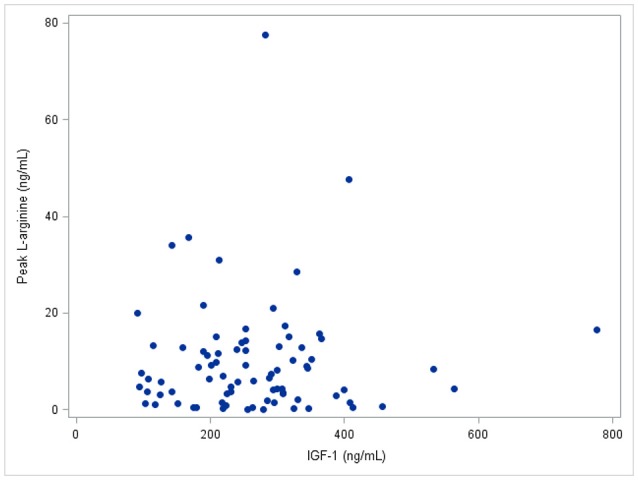
IGF-1 levels vs. peak L-arginine level. The Pearson correlation between IGF-1 and peak L-arginine is 0.03, p > 0.2.